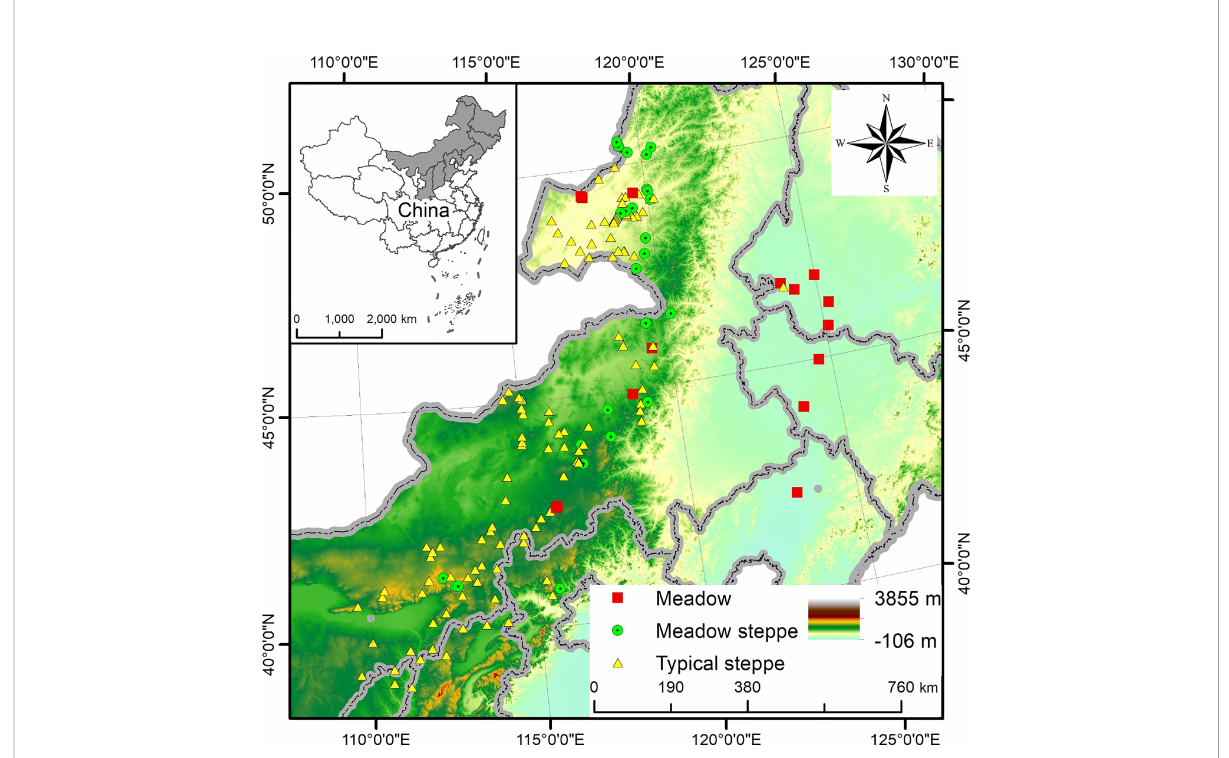
FIGURE 2 Map of the sampling sites of the grasslands dominated by Leymus chinensis . Different shapes and colors show three different community types dominated by L . chinensis in the study